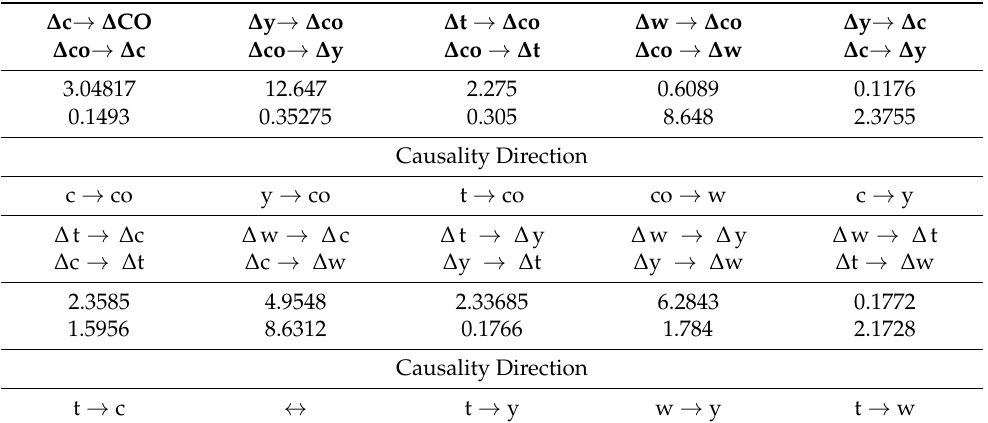
Table 9. The results of the Fourier causality